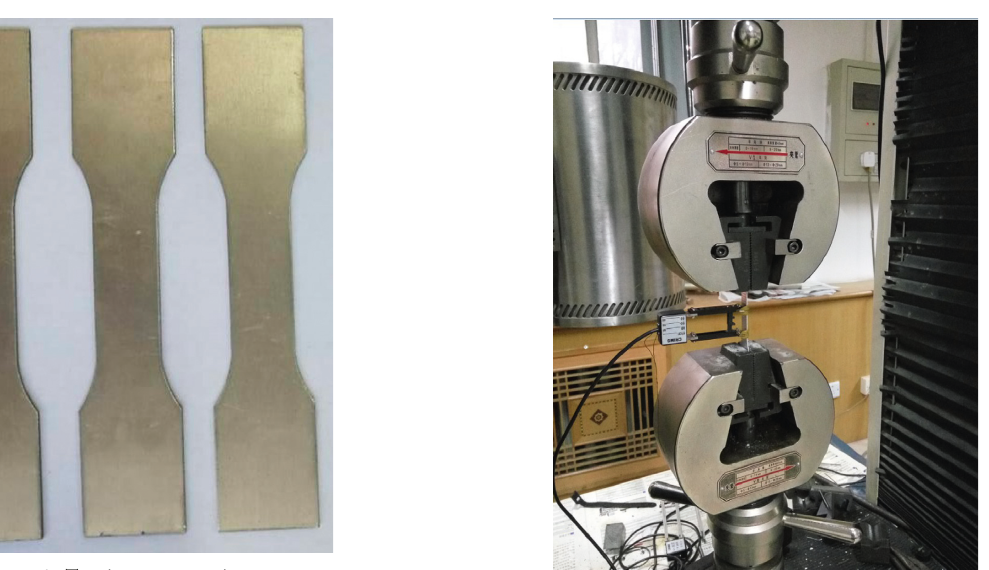
Figure 2: Tension test specimen.